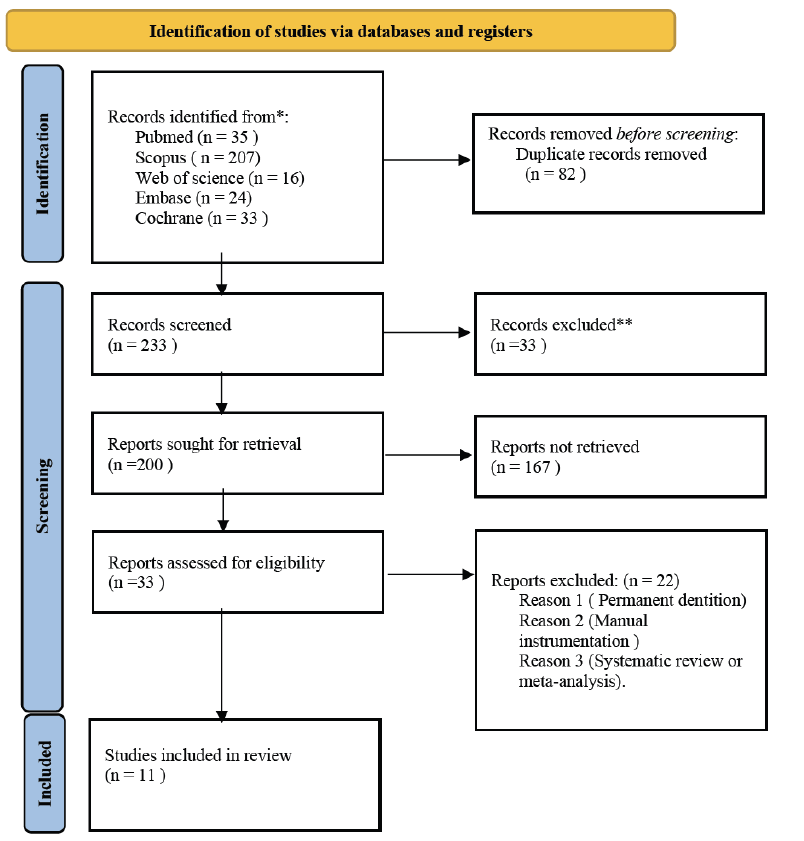
Figure 1. PRISMA flowchart of study selection process. * Consider, if feasible to do so, reporting the number of records identified from each database or register searched (rather than the total number across all databases/registers). ** If automation tools were used, indicate how many records were excluded by a human and how many were excluded by automation tools.